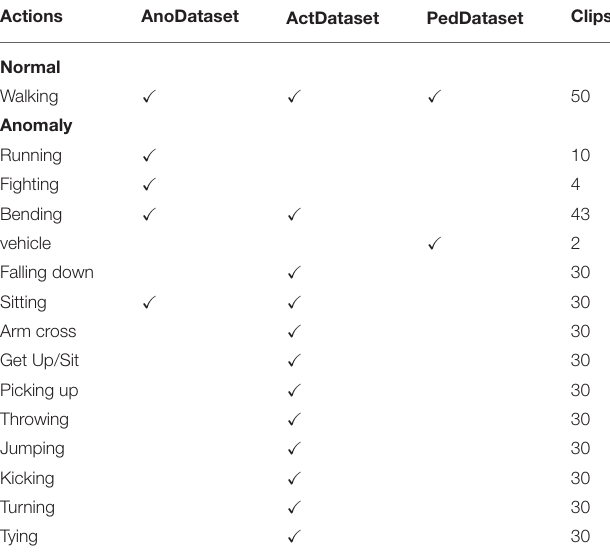
TABLE 1 | Statistics of AnoDataset, ActDataset (Shu et al., 2019), and PedDataset (Shu et al., 2019) used for evaluating the proposed algorithm.